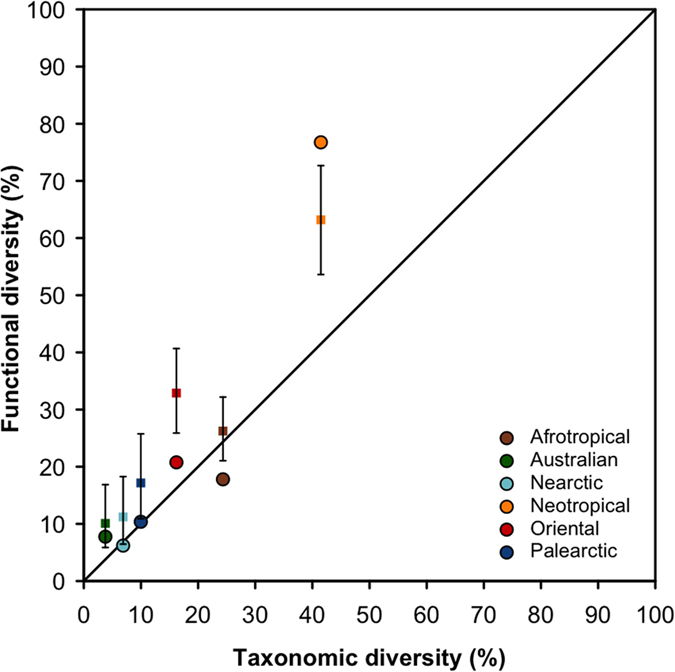
Taxonomic and functional facets of fish biodiversity in the 6 biogeographic realms.Functional diversity (FD) and taxonomic diversity (TD) are expressed as a percentage of the world functional and taxonomic diversity of freshwater fish. The effect of species identity on functional diversity is represented by the mean (colored squares) and associated 95% confidence interval (black whiskers) computed on 999 values of a null model. This null model simulated realm assemblages using random sampling in the world pool of species, while conserving the taxonomic structure of the realm fauna (i.e. number of species per order). Observed values of FD above the whiskers indicate a significant functional overdispersion, whereas values below the whiskers indicate significant functional clustering. The solid line represents the identity line FD = TD. Each color refers to one realm.